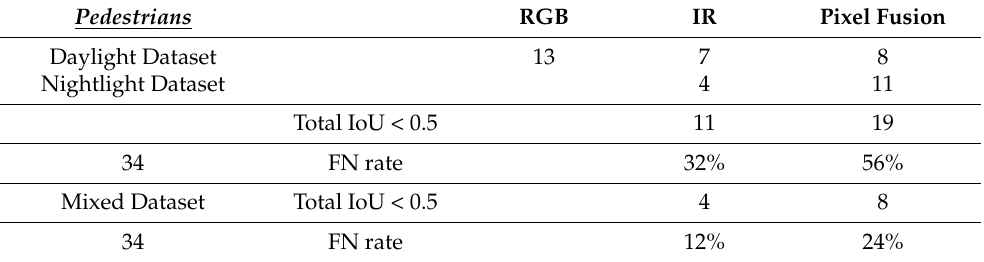
Table 8. Number of images out of Test DS images in which the trained networks failed to classify pedestrians with IoU detection rate higher than 0.5. Columns: DSs used to train the networks (i.e., RGB images, IR images, and pixel-level fused images). Rows: actual part of the dataset the network was trained with (i.e., Daylight dataset, Nightlight dataset and Mixed dataset). Pedestrians RGB IR Pixel Fusion Daylight Dataset 13 7 8 Nightlight Dataset 4 11 Total IoU < 0.5 11 34 FN rate 32% 56% Mixed Dataset Total IoU <